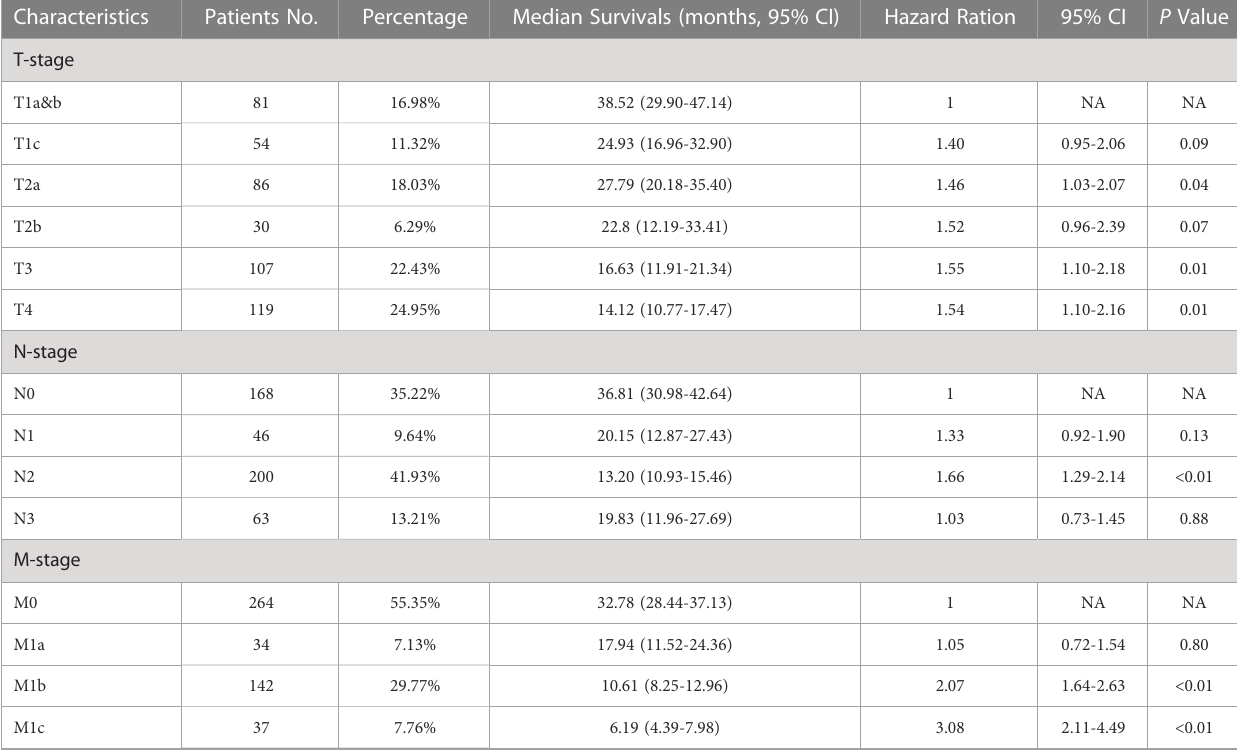
TABLE 2 TNM stage characteristics, median overall survivals, and multivariable cox regression for patients with C-SCLC. Characteristics Patients No. Percentage Median Survivals (months, 95% CI) Hazard Ration 95% CI P